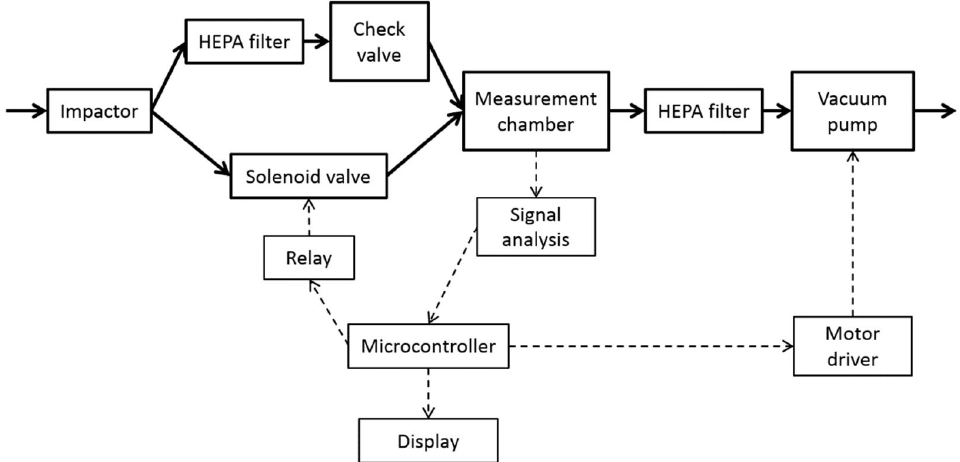
Figure 2. Block diagram of the designed nanoparticle detector.